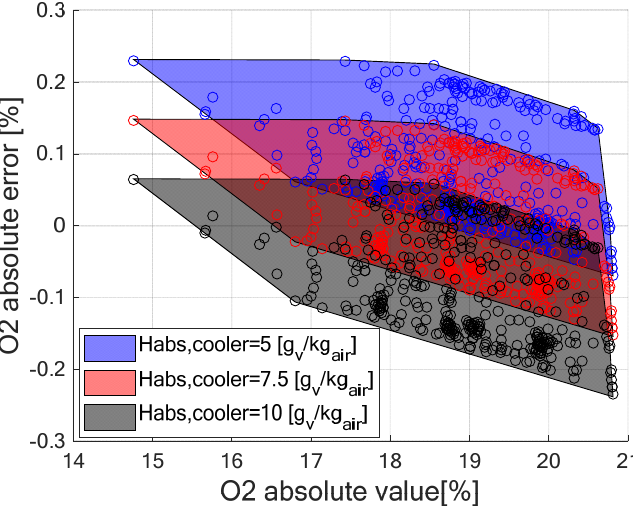
Figure 7. Differences between the values of the intake O 2 concentration predicted by the newly developed procedure (corrected with Equation (25), assuming different values of H abs,cooler , in order to consider the presence of residual humidity in the gases exiting the analyzer cooler) and the values measured by the O 2 analyzer, as a function of the absolute values of the intake O 2 .